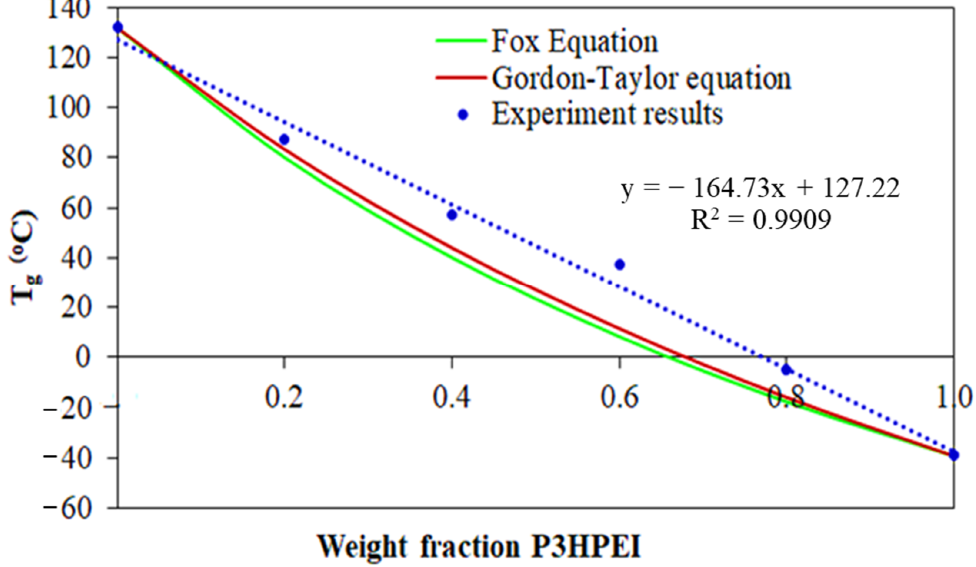
Figure 8. Correlation between weight fraction of P3HPEI and T g of experimental results, compared with theoretical results.